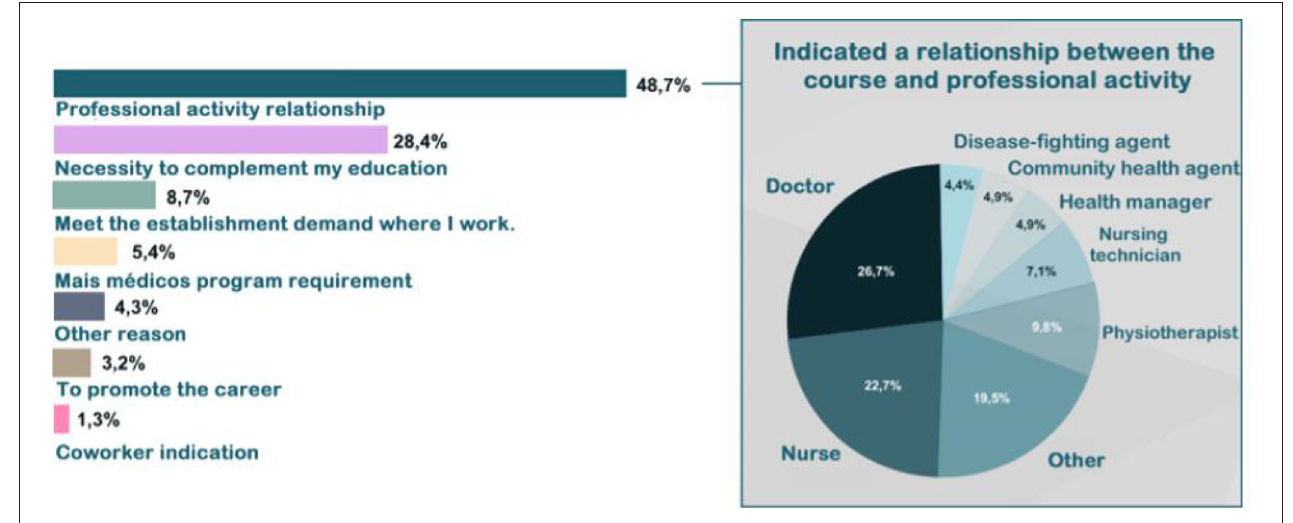
FIGURE 8 | AVASUS contribution to the work.